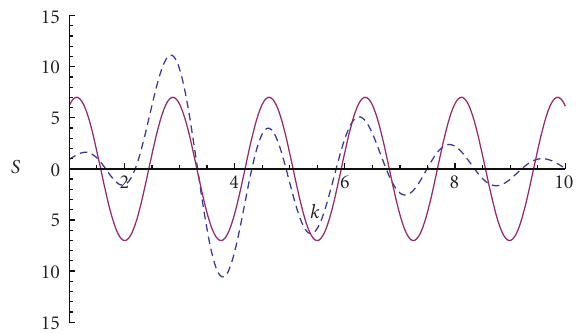
Figure 7: Numerical result (dashed line) for the bispectrum running for a sharp step ( c = 0 . 0018, d = 0 . 022) along the k 1 = k 2 = k 3 ≡ k direction, compared with the simple ansatz (137) (solid